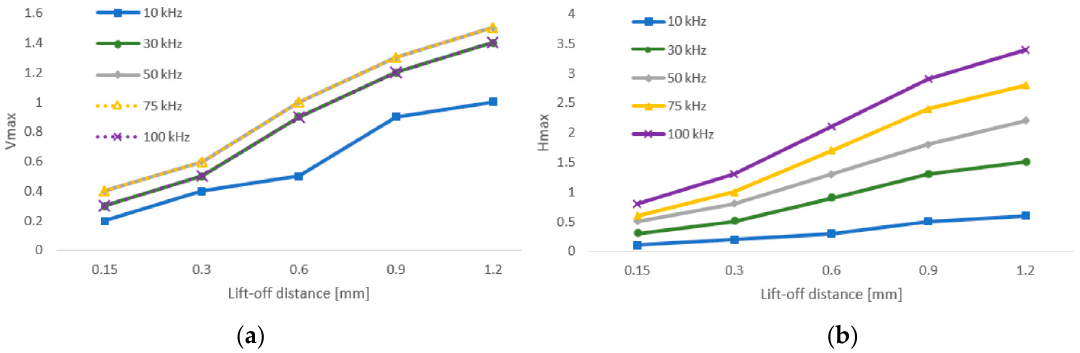
Figure 4. Vmax ( a ) and Hmax ( b ) signal-to-lift-off variation (P1 probe).